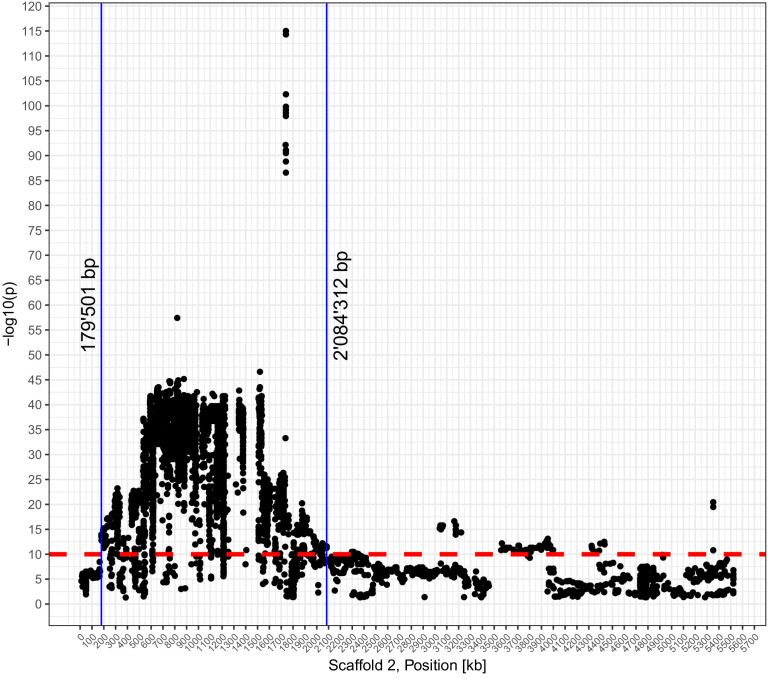
Genome-wide association mapping (GWAS) outcome for the mating type (MAT) locus.The red line shows the p-value-based threshold to exclude MAT-locus-associated single nucleotide polymorphisms (SNPs) for population structure analyses.